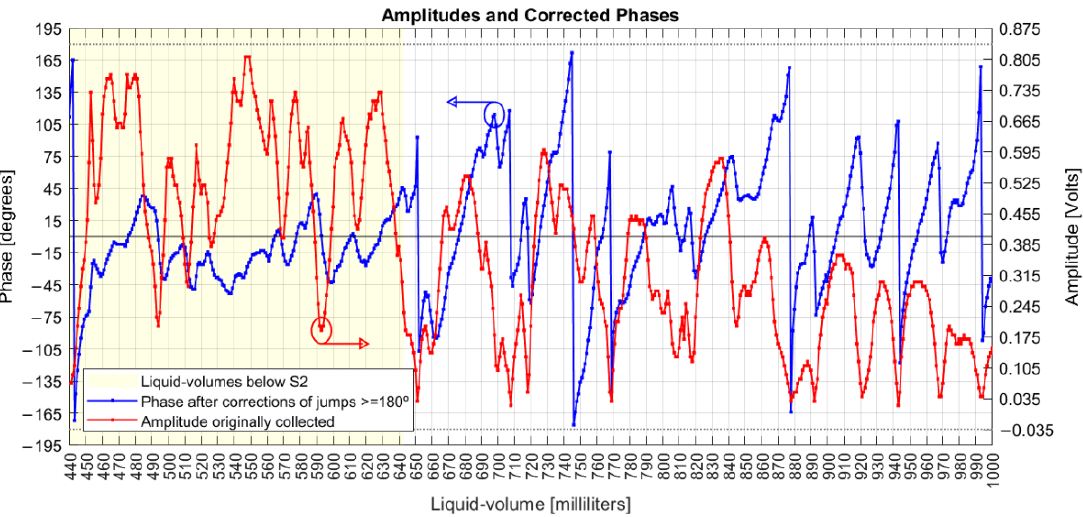
Figure 8. Original amplitudes and corrected phases.